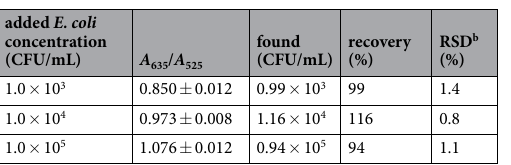
Table 1. Recovery studies of spiked E . coli O157:H7 in fresh milk samples a . a Average of three parallel tests. b RSD represents relative standard deviation for absorption